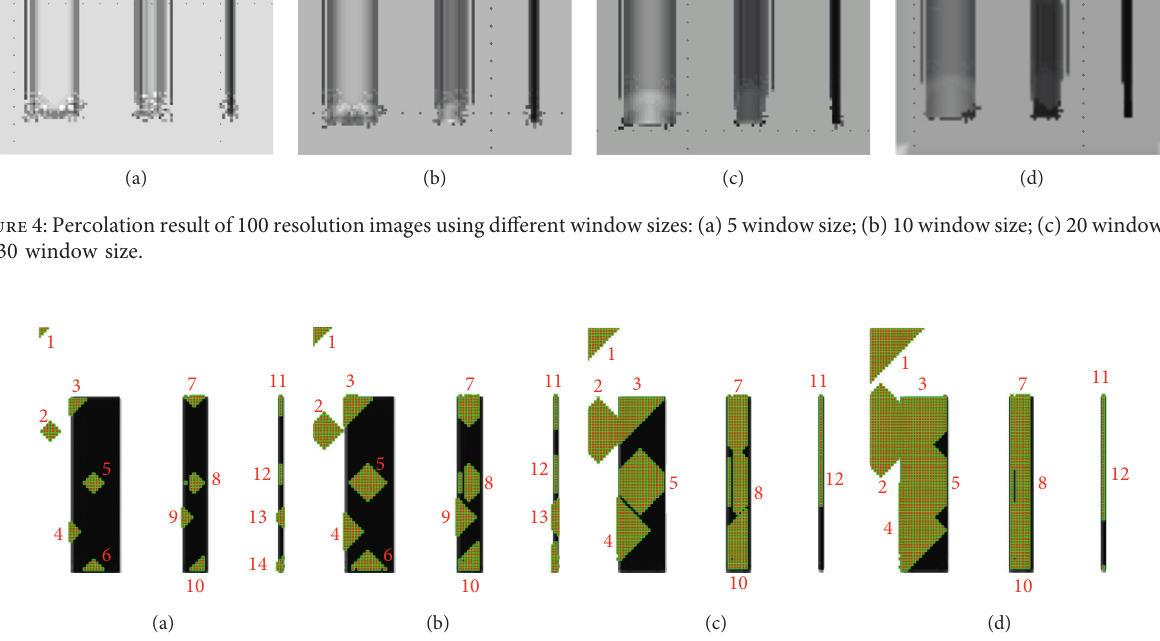
Figure 5: Percolation areas of 14 pixels using different window sizes: (a) 5 window size; (b) 10 window size; (c) 20 window size; (d) 30 window size.